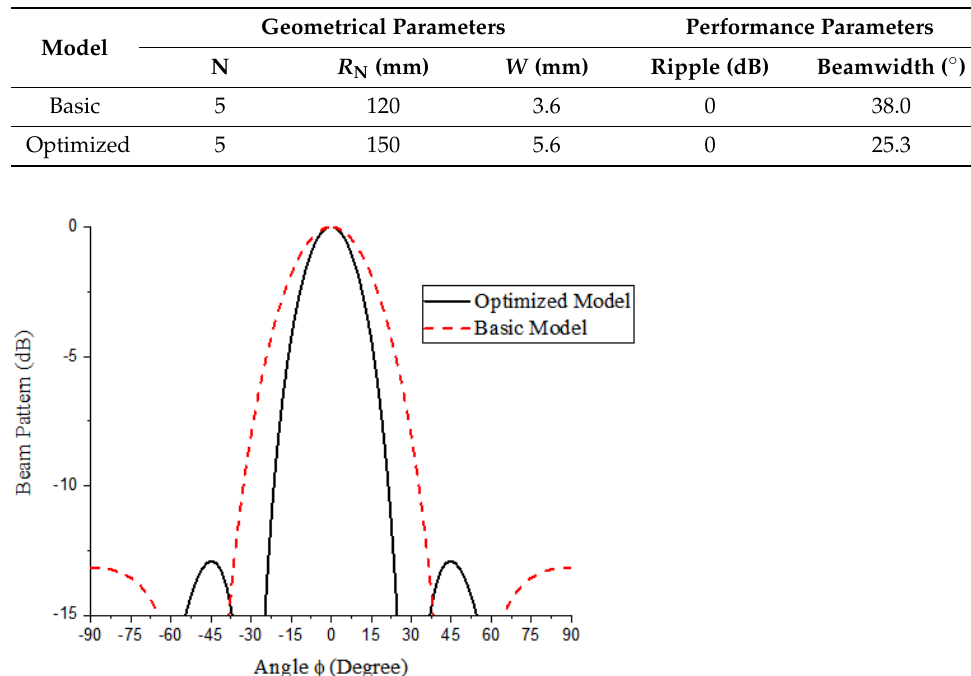
Table 4. Comparison between basic and optimized models for the N-subarray part.